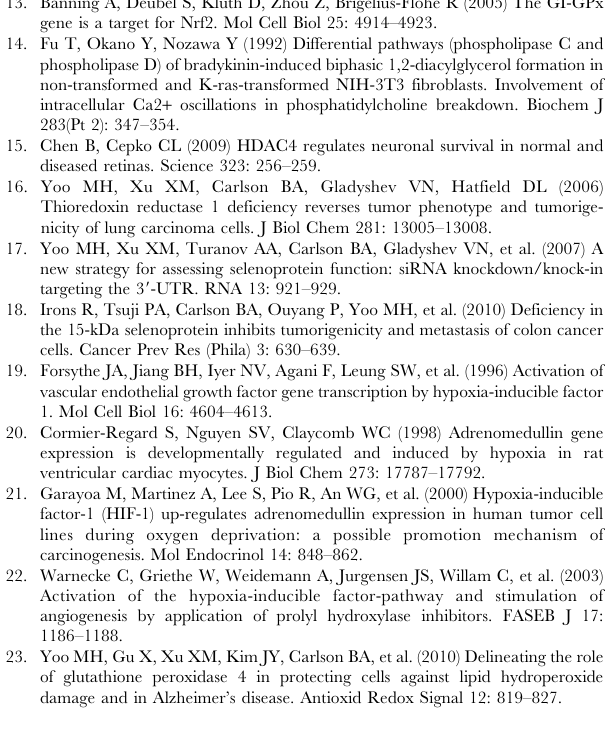
Figure S1 Knockdown of TR1 in EMT6 and DT cells. EMT6 and DT cells were infected with retroviruses encoding a TR1 shRNA (siTR1) or a scramble sequence as a control. RNA was collected from control and knockdown cells and TR1 mRNA levels determined by quantitative PCR and normalized by the content of b -actin. A value of 1 (solid line) was assigned to the normalized TR1 level of control cells. The normalized levels of TR1 in knockdown cells samples are represented as fold over control samples. Data show the results obtained in three independent experiments and their average values. (TIF) Figure S2 Over-expression of TR1 in EMT6 and DT cells. EMT6 and DT cells were infected with empty retroviruses (Ctrl) or with retroviruses encoding the TR1 gene (TR1). (A) TR1 mRNA levels were measured by quantitative RT-PCR and normalized by the content of b -actin. Data show the average fold-change over control of three independent experiments 6 SE. (B) TR1 and b -actin protein levels were determined by western blotting in EMT6 or DT TR1 over-expressing cells.